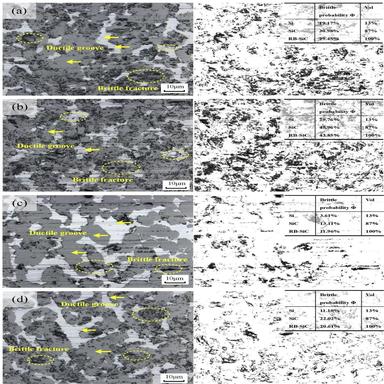
Typical surface morphologies of RB-SiC under different grinding parameters of (a) vs = 20 m/s vw = 0.170 m/s ap = 1.5 μm (b)vs = 10 m/s vw = 0.170 m/s ap = 1.5 μm (c) vs = 20 m/s vw = 0.057 m/s ap = 1.5 μm (d) vs = 20 m/s vw = 0.170 m/s ap = 0.5 μm.